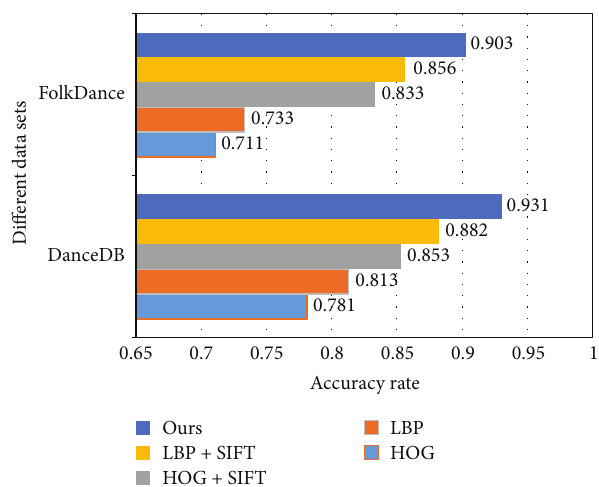
Figure 6: Comparison of experimental results using different feature extraction